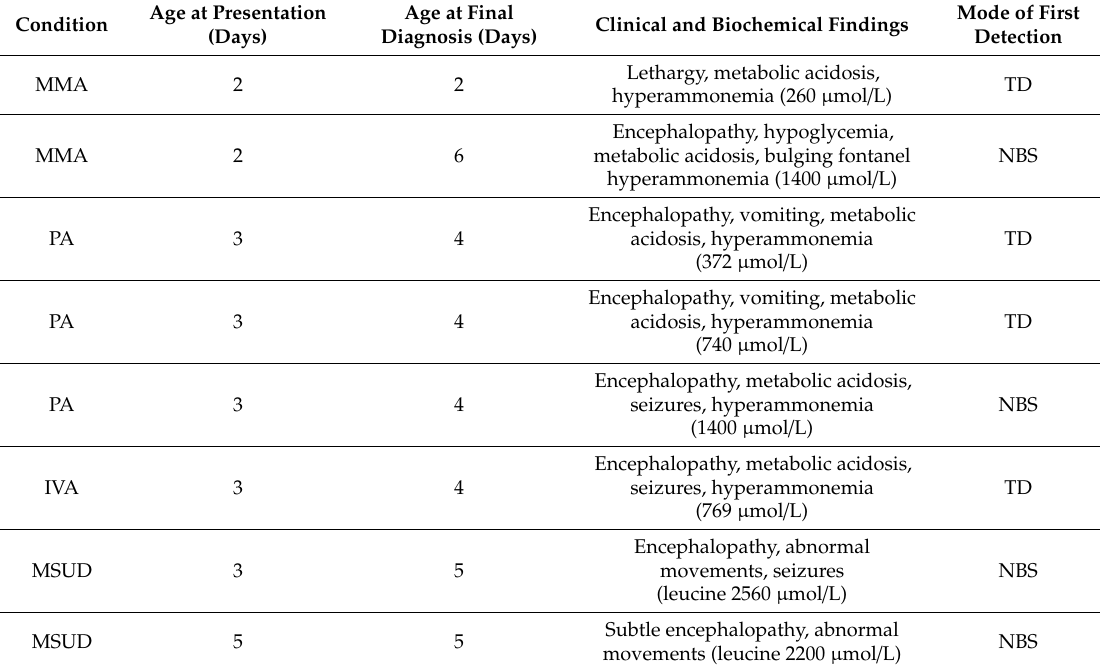
Table 3. Newborns presenting with symptoms ( n = 16 / 75) before NBS results were